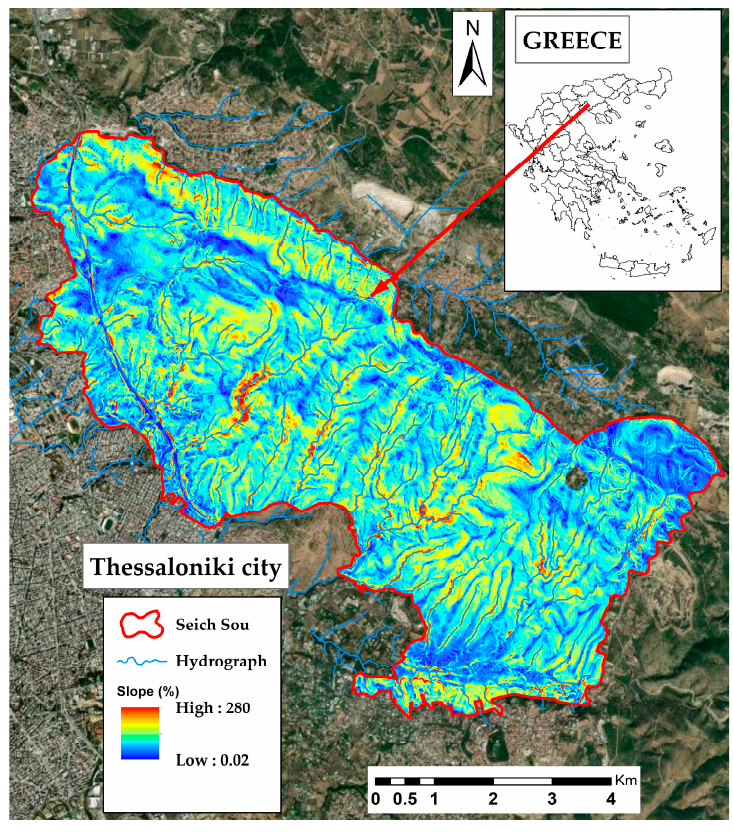
Figure 7. The topography and the dominant slopes of the study area.